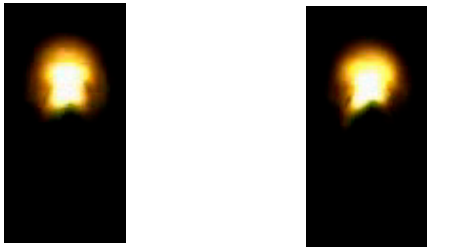
Figure 11. Two examples of cuts missclassified as burr.